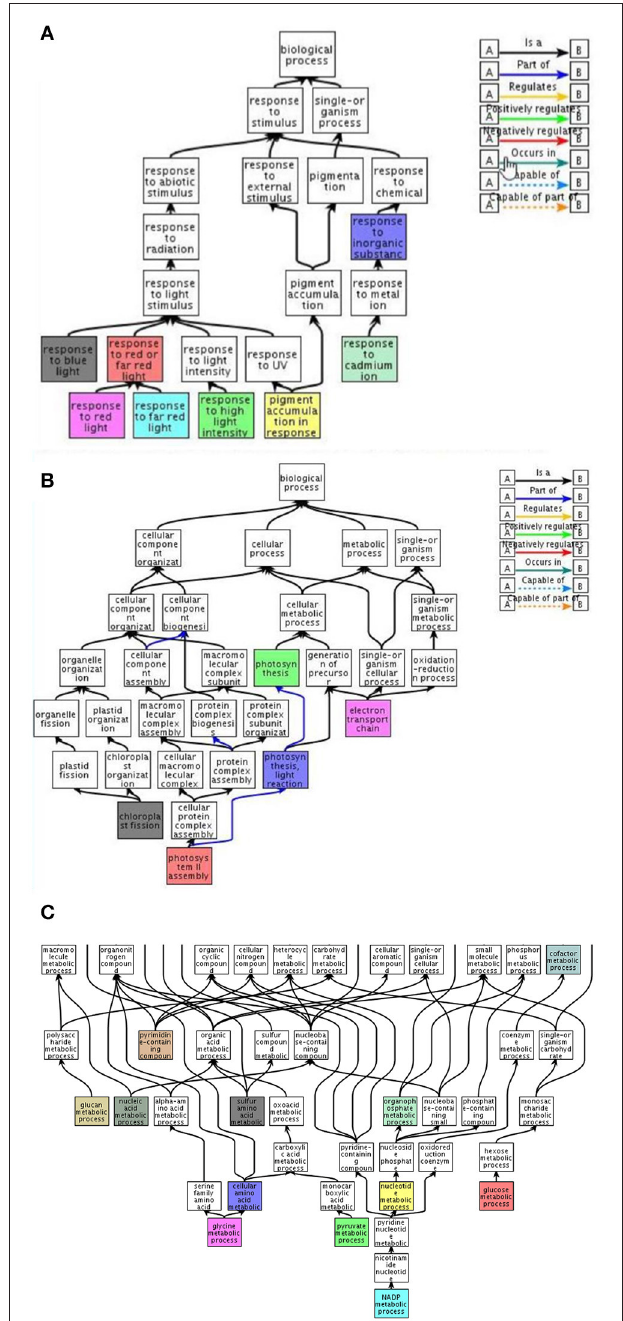
FIGURE 7 | Functional classification of gene clusters displaying CK-dependent increased expression under salinity stress. QuickGo representation of up-regulated Gene Ontology groups identified by the enrichment analysis of the RNA sequencing data. These gene clusters are characterized by transcriptional suppression under salinity stress and moderate suppression with CK (clusters 5, 6, and 7). Functional identification was performed with the QuickGO platform (A) https://www.ebi.ac.uk/Quick GO/GMultiTerm#a = 64%2402Mb02Md02Mi02Sp02U202Vg0AdM0BPU& tab = chart&c = ; (B) https://www.ebi.ac.uk/QuickGO/GMultiTerm#a = 64%